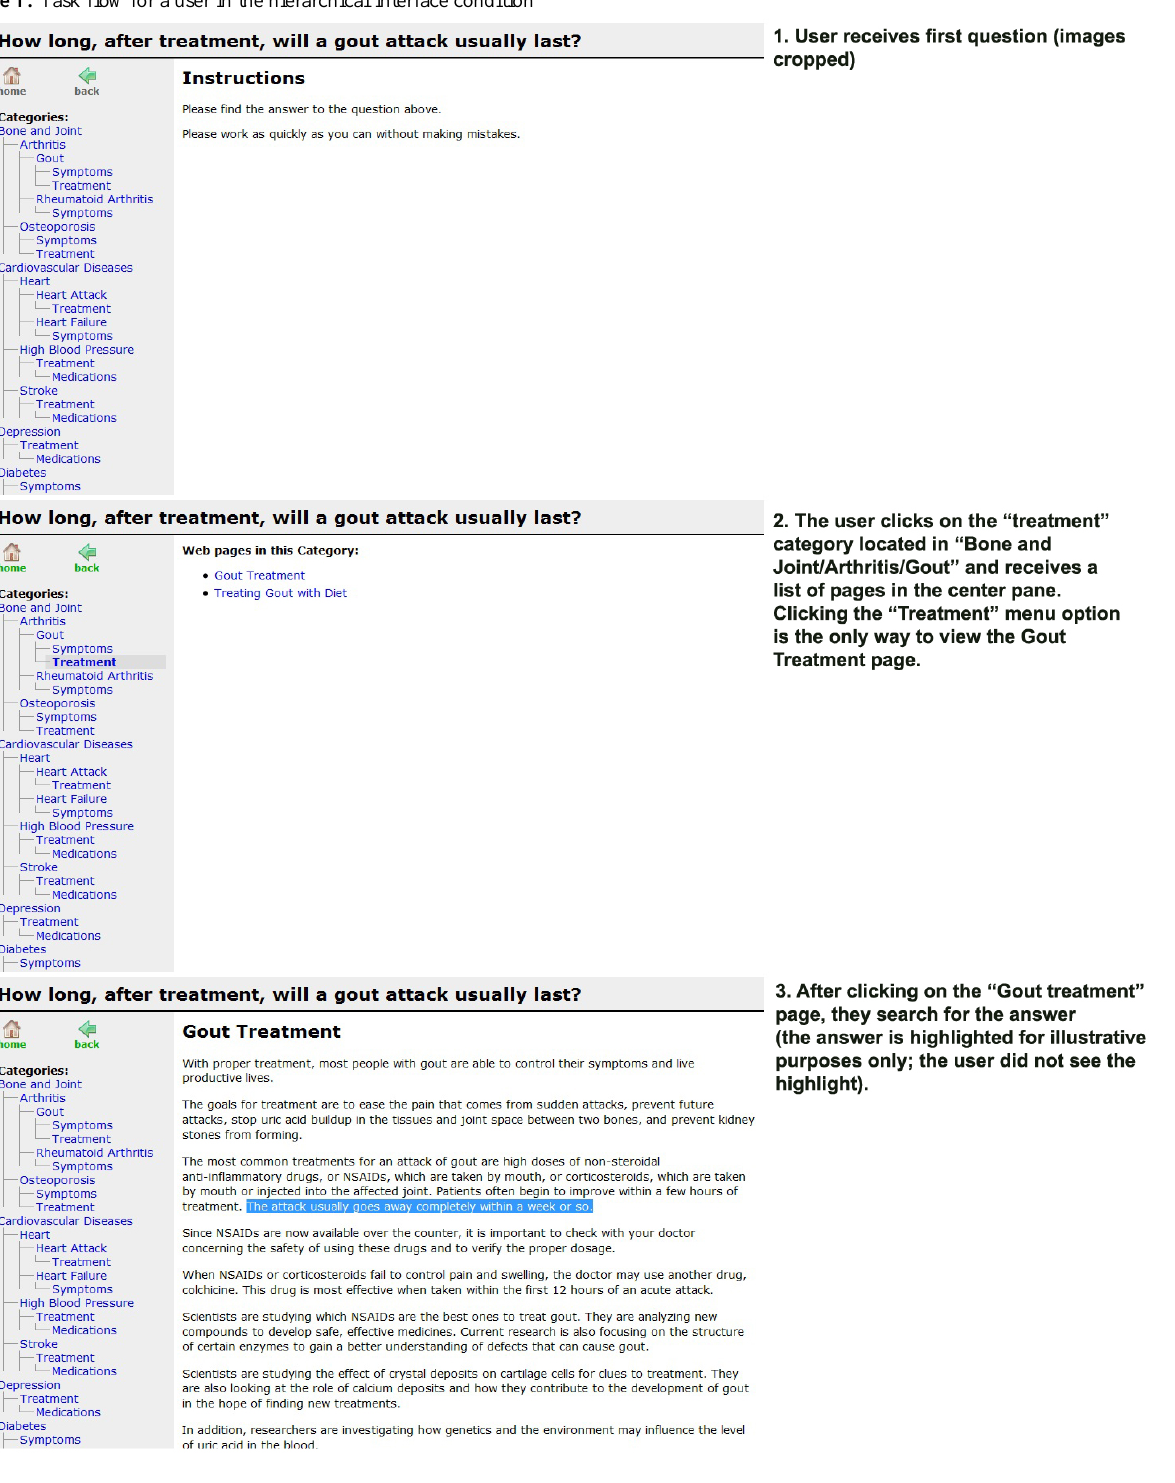
Figure 1. Task flow for a user in the hierarchical interface